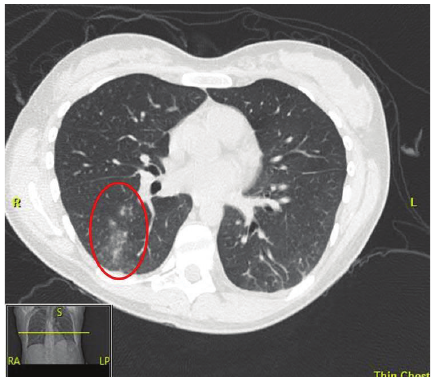
Figure 2: Ground glass opacities in the right lower lobe consistent with an acute inflammatory process.